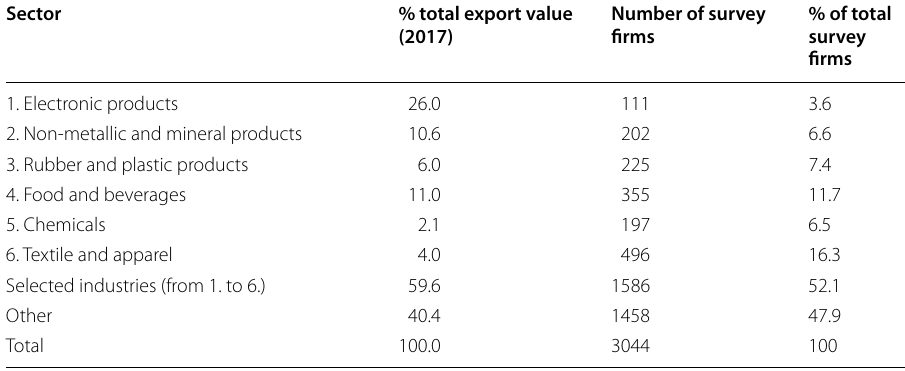
Source: author’s calculations using World Bank Enterprise Survey and ASEAN Secretariat